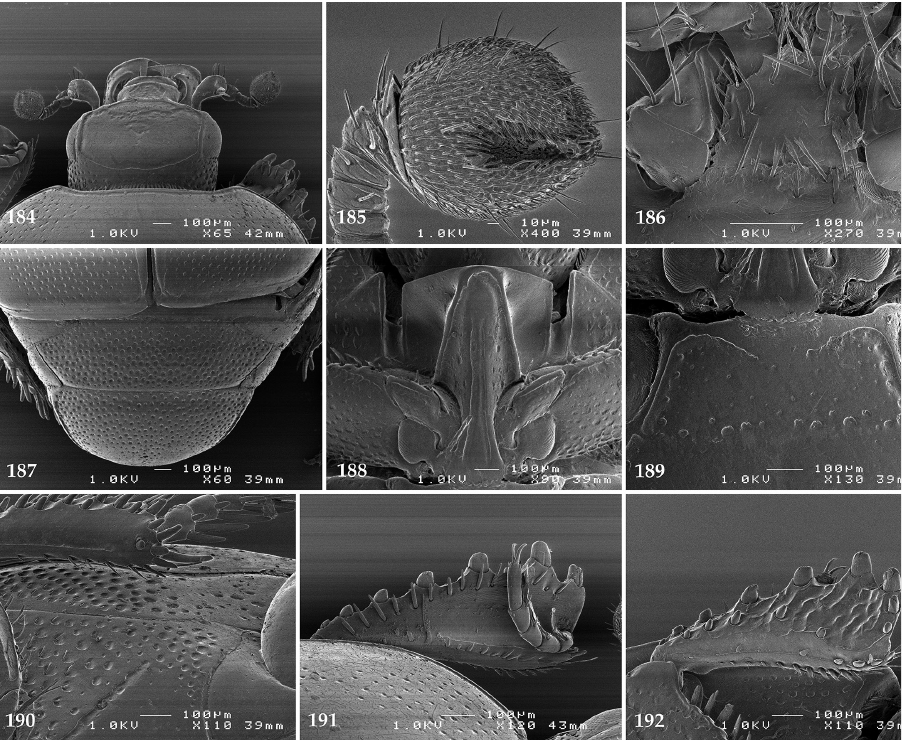
Figures 184–192. 184 Hypocaccus ( Baeckmanniolus ) varians varians (Schmidt, 1890) head, dorsal